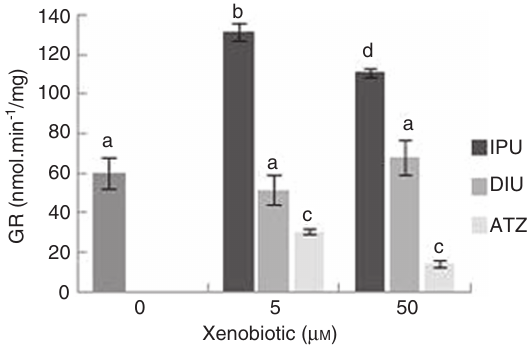
Figure 5: GR activity of post-12,000 g supernatant of Saccharomy- ces cerevisiae UE-ME grown in YEPD medium, in the absence or 3 presence of IPU, DIU and ATZ. The results represent the mean of five independent experiments ± SEM. The bars marked with different letters are significantly differ- ent (p < 0.01).